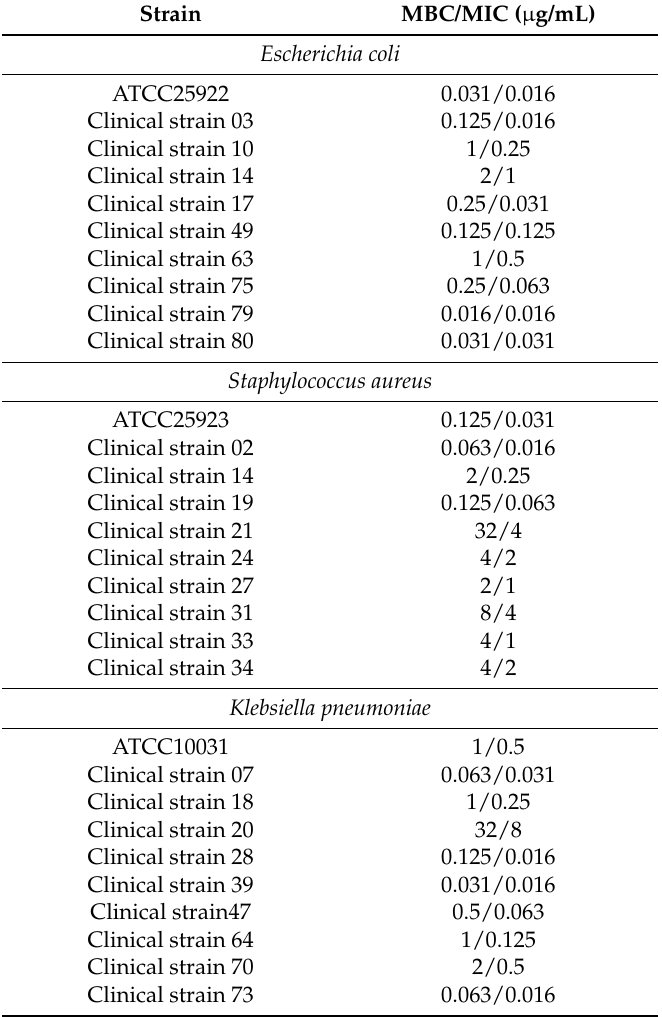
Table 3. MBC/MIC values of tebipenem pivoxil in Escherichia coli , Staphylococcus aureus , and Klebsiella pneumonia